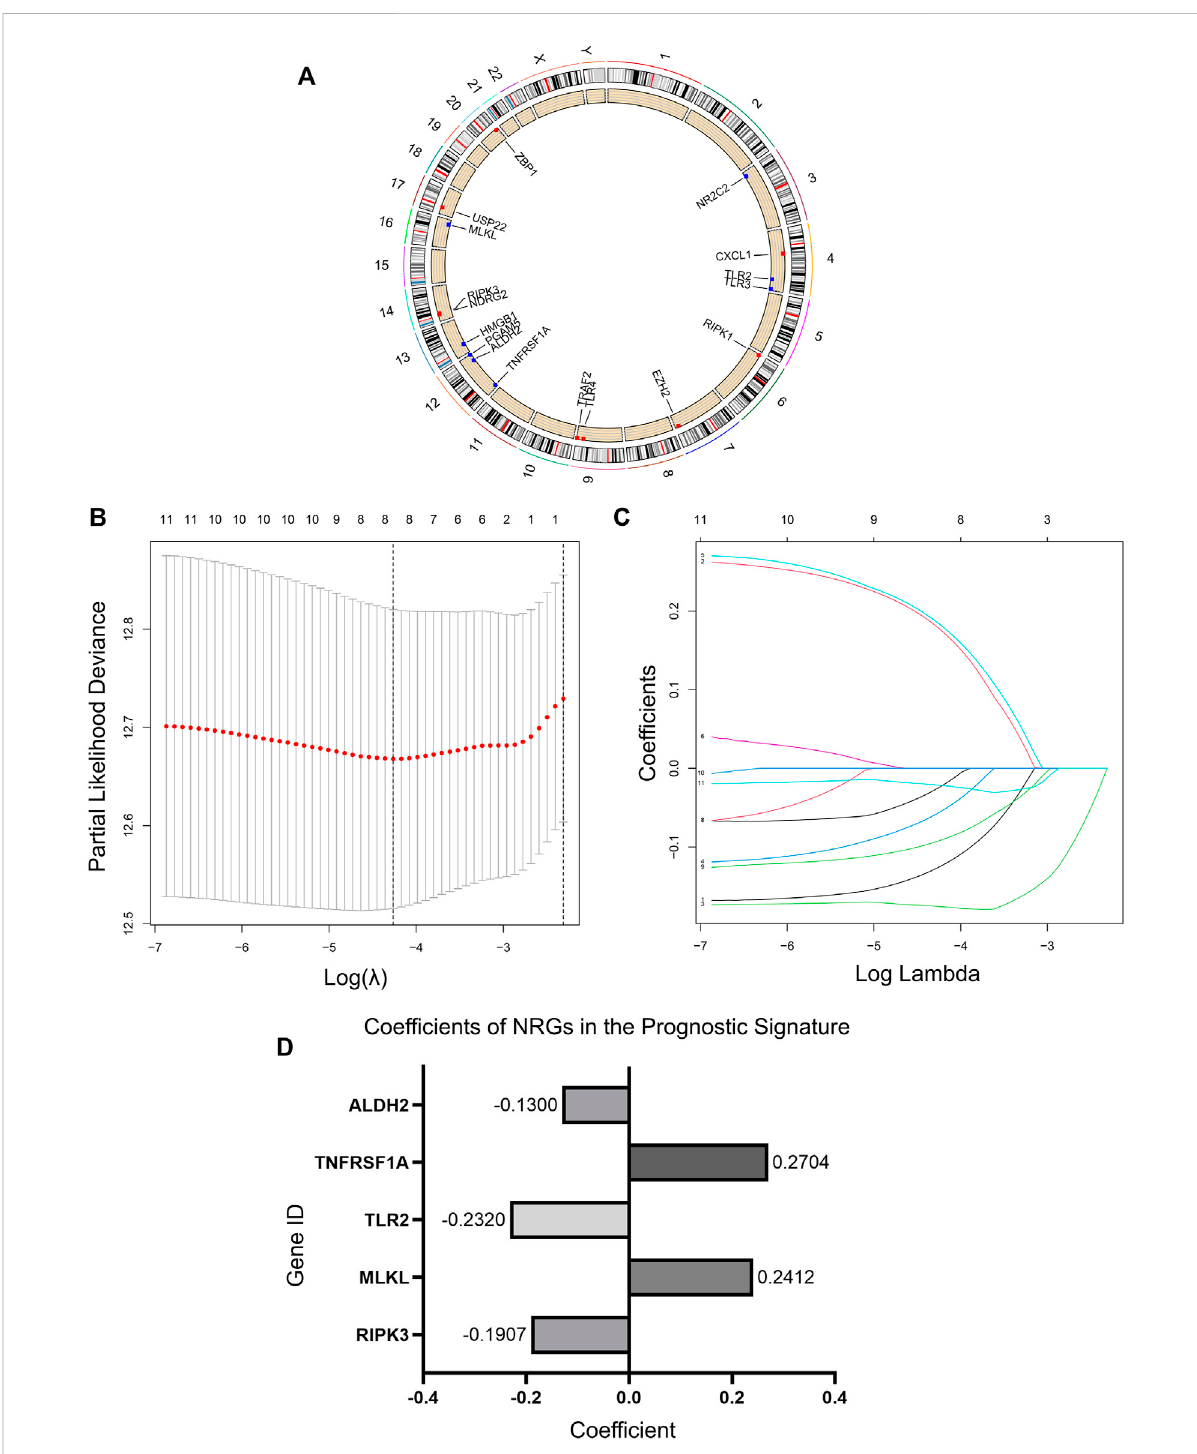
FIGURE 2 Necroptosis regulators in LUAD and an NRG signature. (A) Location of NRGs on chromosomes. (B) Ten-fold cross-validation for tuning parameterselectioninthelassoregression.Theverticallinesareplottedbasedontheoptimaldataaccordingtotheminimumcriteriaand1-standard error criterion. The left vertical line represents the fi ve genes fi nally identi fi ed. (C) LASSO coef fi cient pro fi les of 11 candidate genes and an optimal model derived from them. (D) 5 NRGs and their coef fi cients in the prognostic